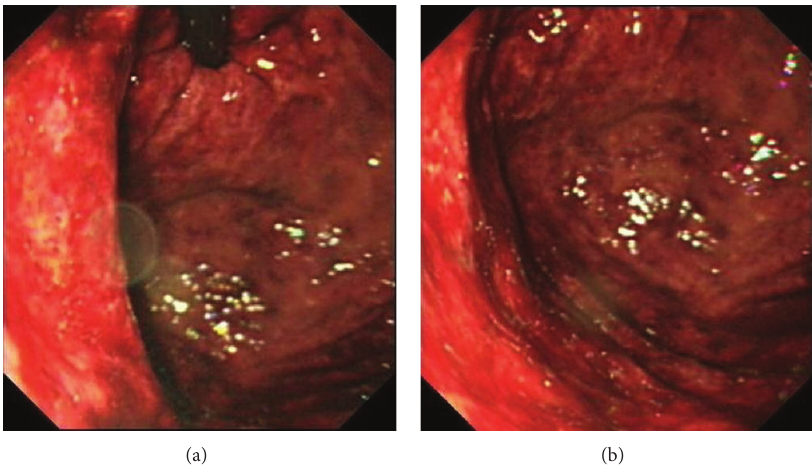
Figure 4: Intraoperative upper endoscopy showed congestion of gastric